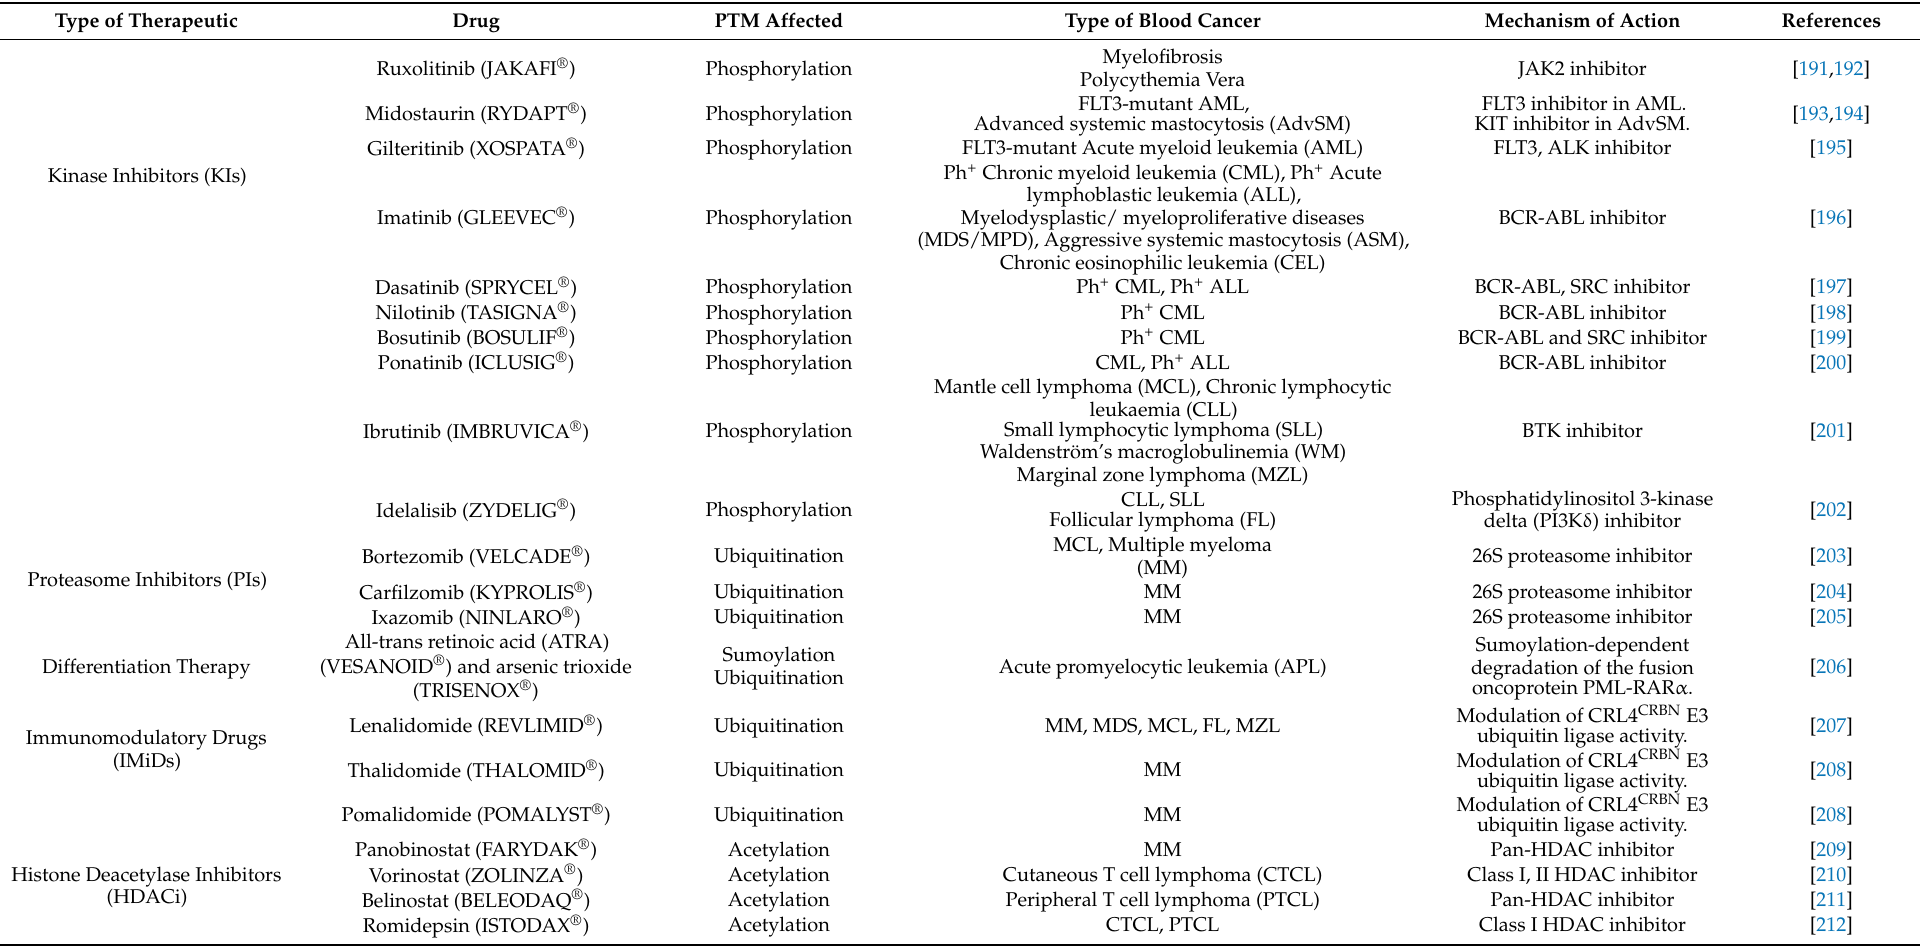
Table 1. Current FDA-approved therapeutics for the treatment of various blood cancers that influence protein